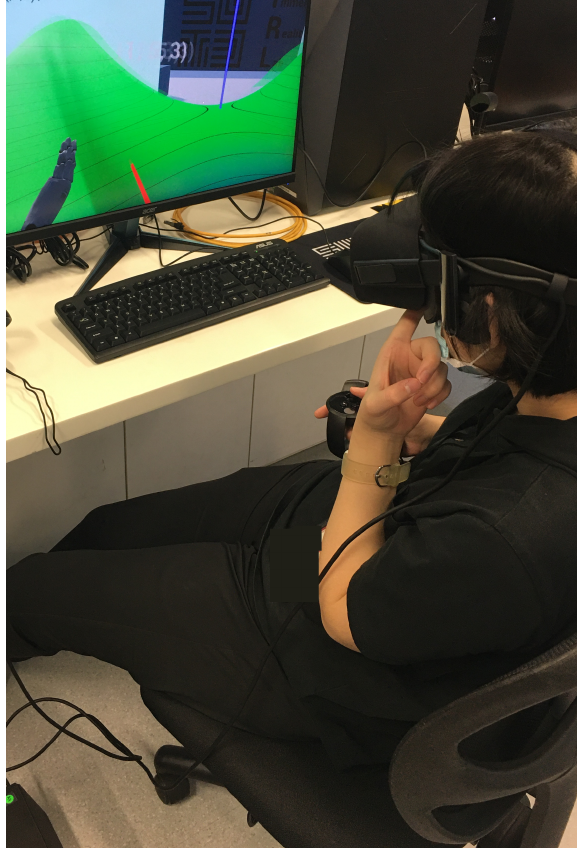
Figure 4. A student interacts with the object while being immersed in the virtual reality environment.